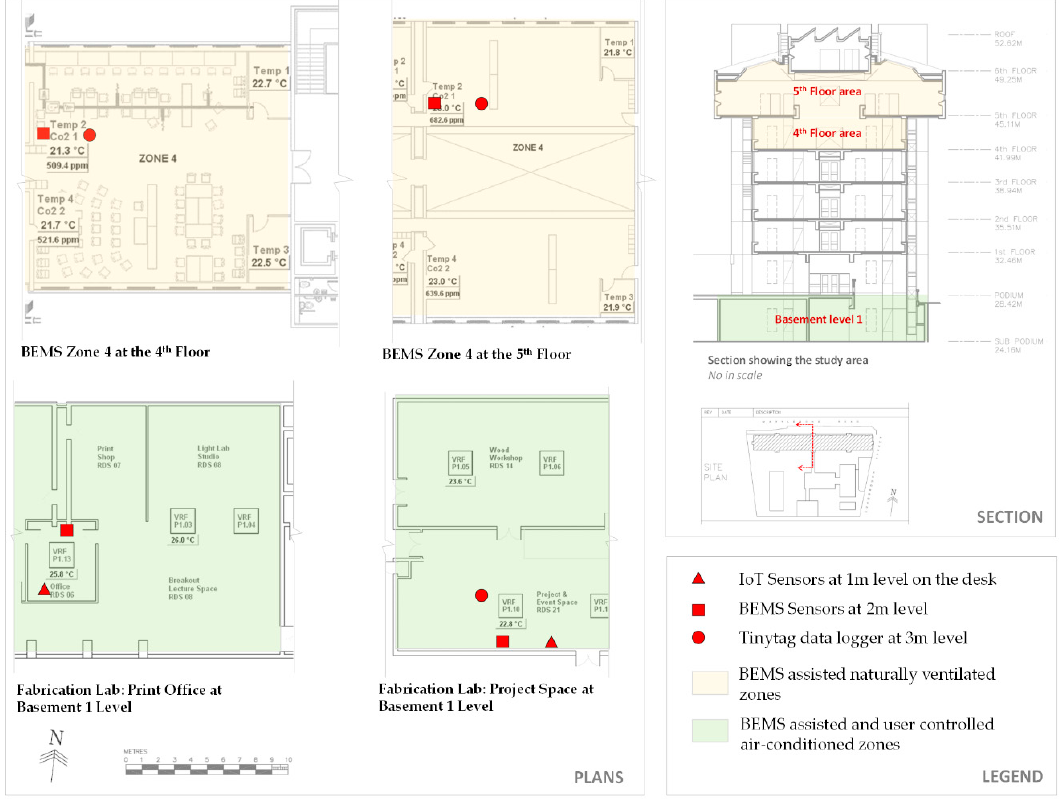
Figure 5. Studied areas for BEMS, IoT and Tinytag sensors.